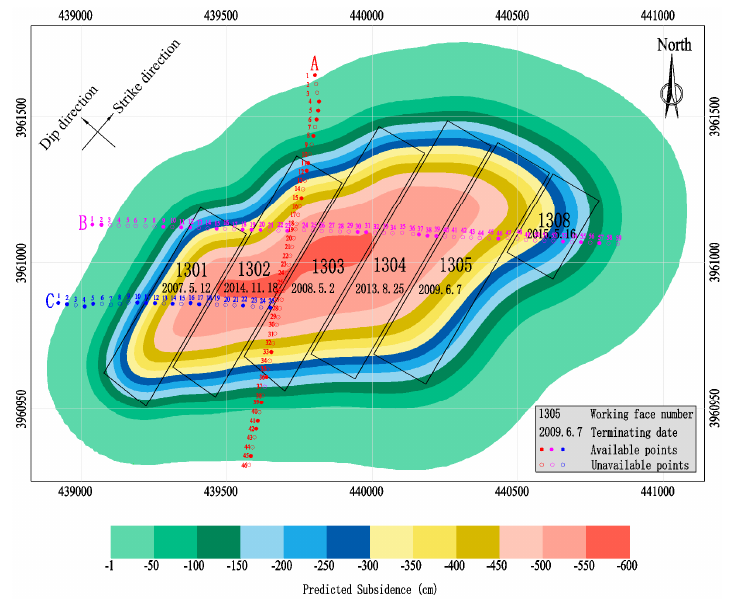
Figure 12. Mining area and the location of ground observation lines. Appl. Sci. 2020 , 10 , x FOR PEER REVIEW